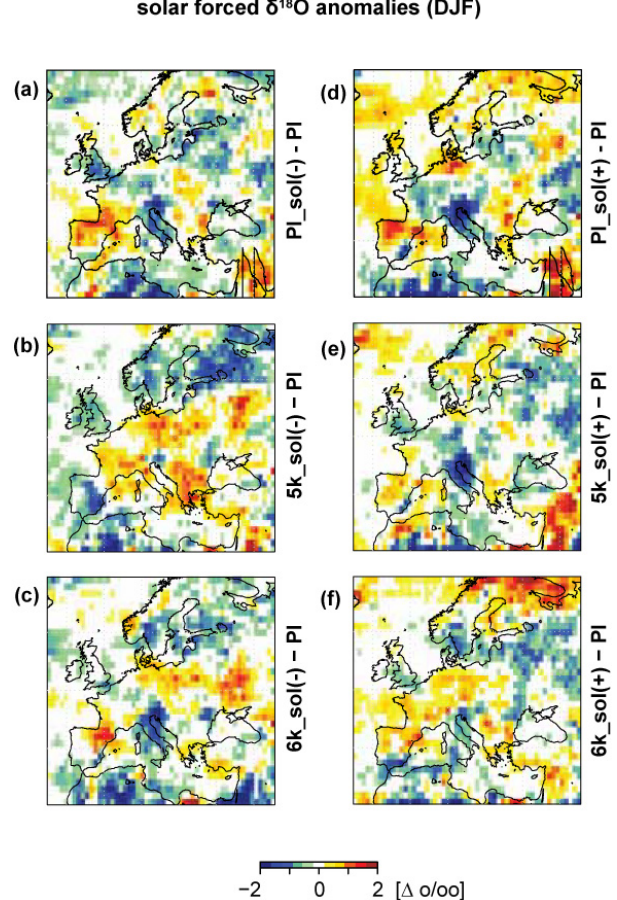
Fig. 11. Combined orbital-driven insolation and solar activity- induced winter (DJF) δ 18 O anomalies for PI, 5k, and 6k. The left column (a–c) shows simulation results for weak solar activity, the right column (d–f) for high solar